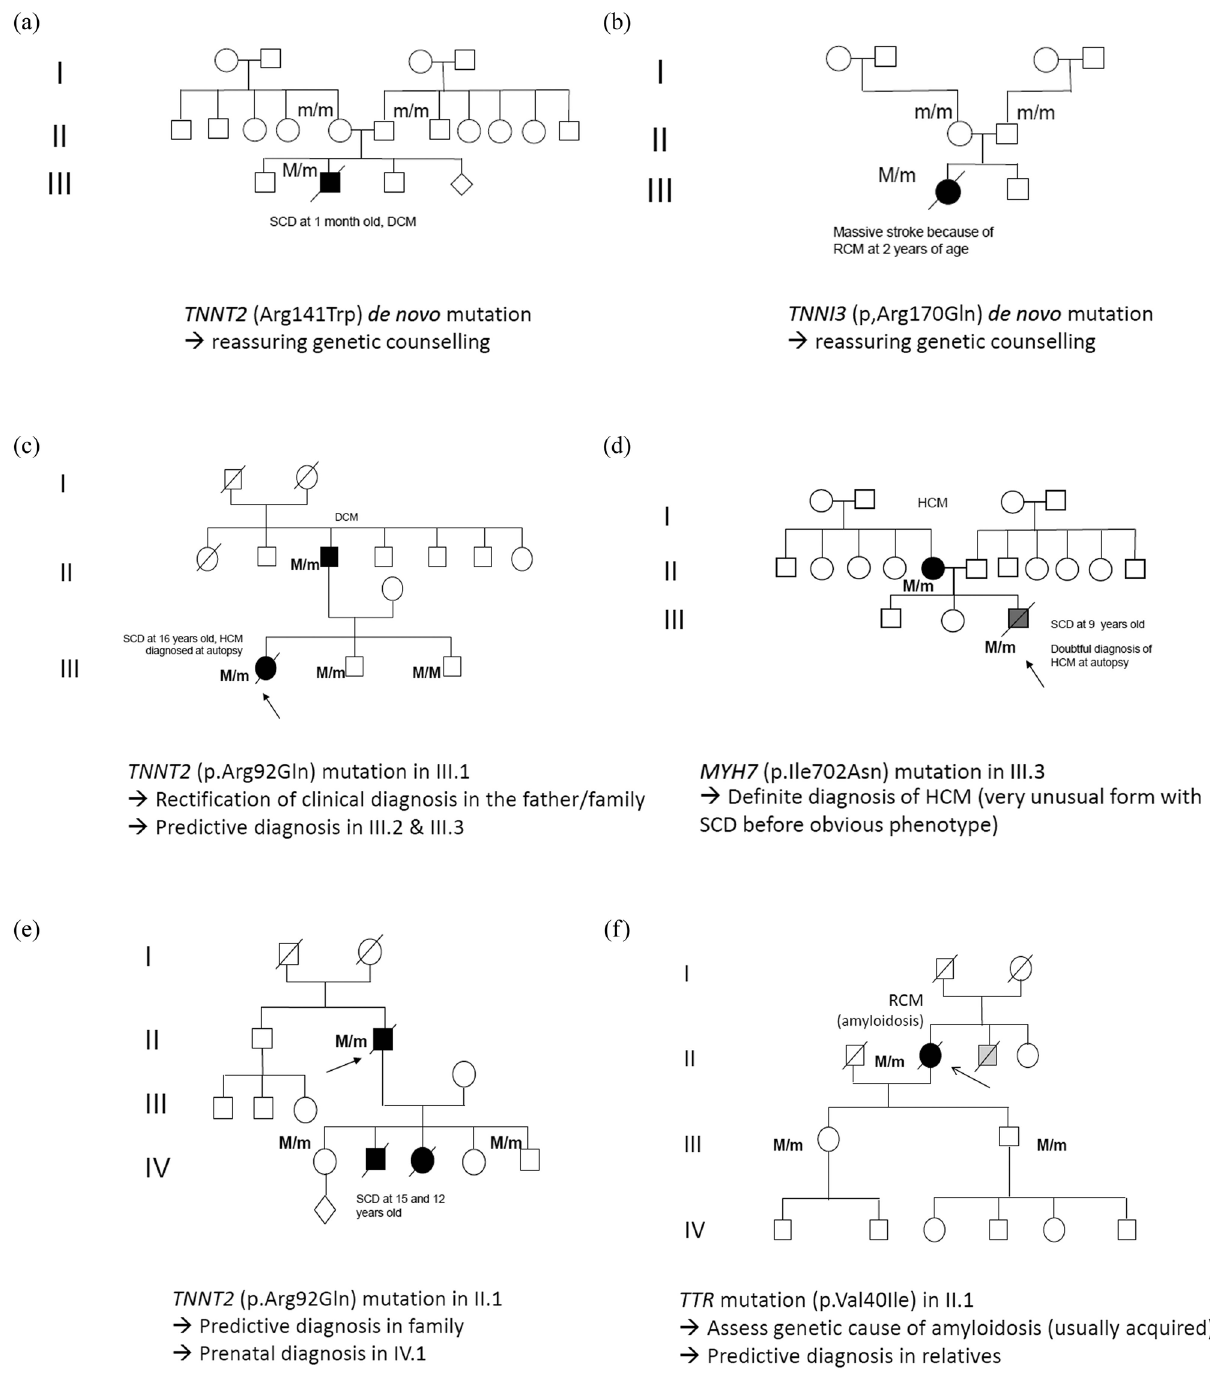
Figure 2: Selected pedigrees of patients with a causal variant and particular medical impact in the